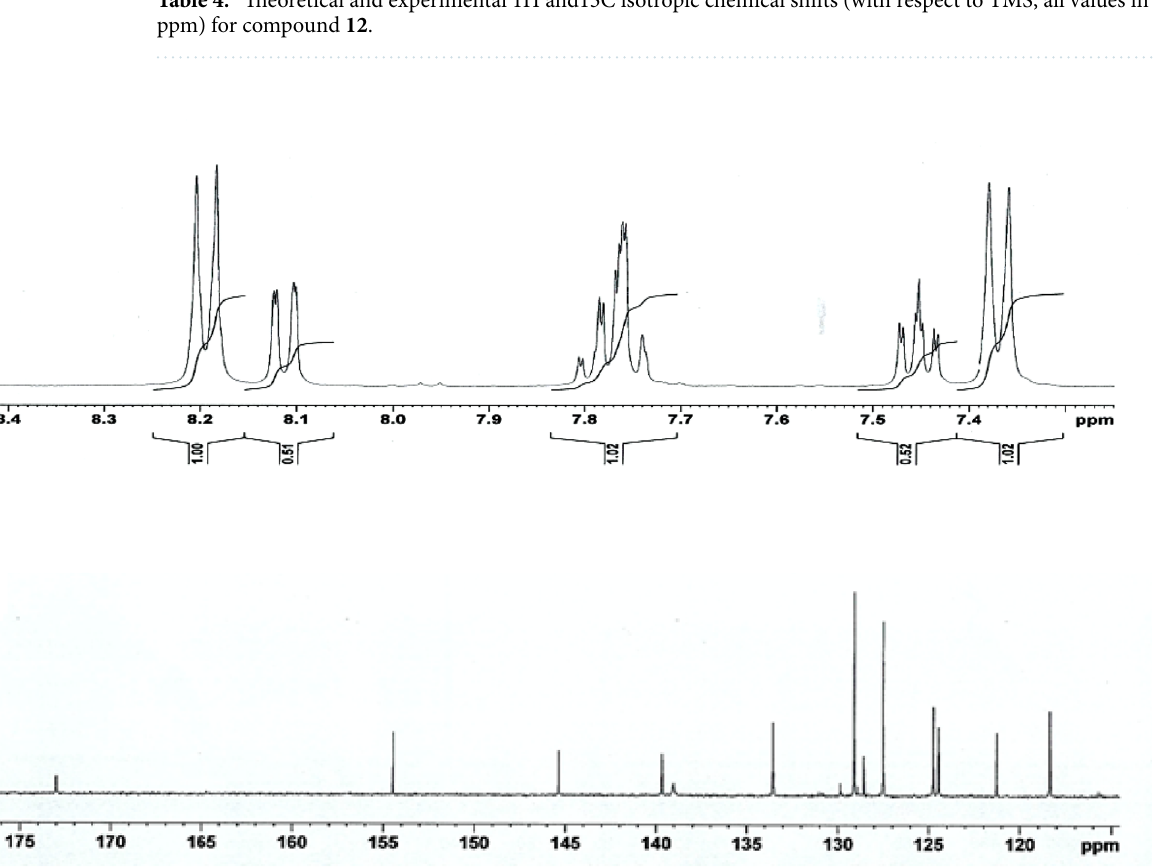
Figure 17. The experimental ( a ) 1 H and ( b ) 13 C NMR spectra of compound 12 in DMSO